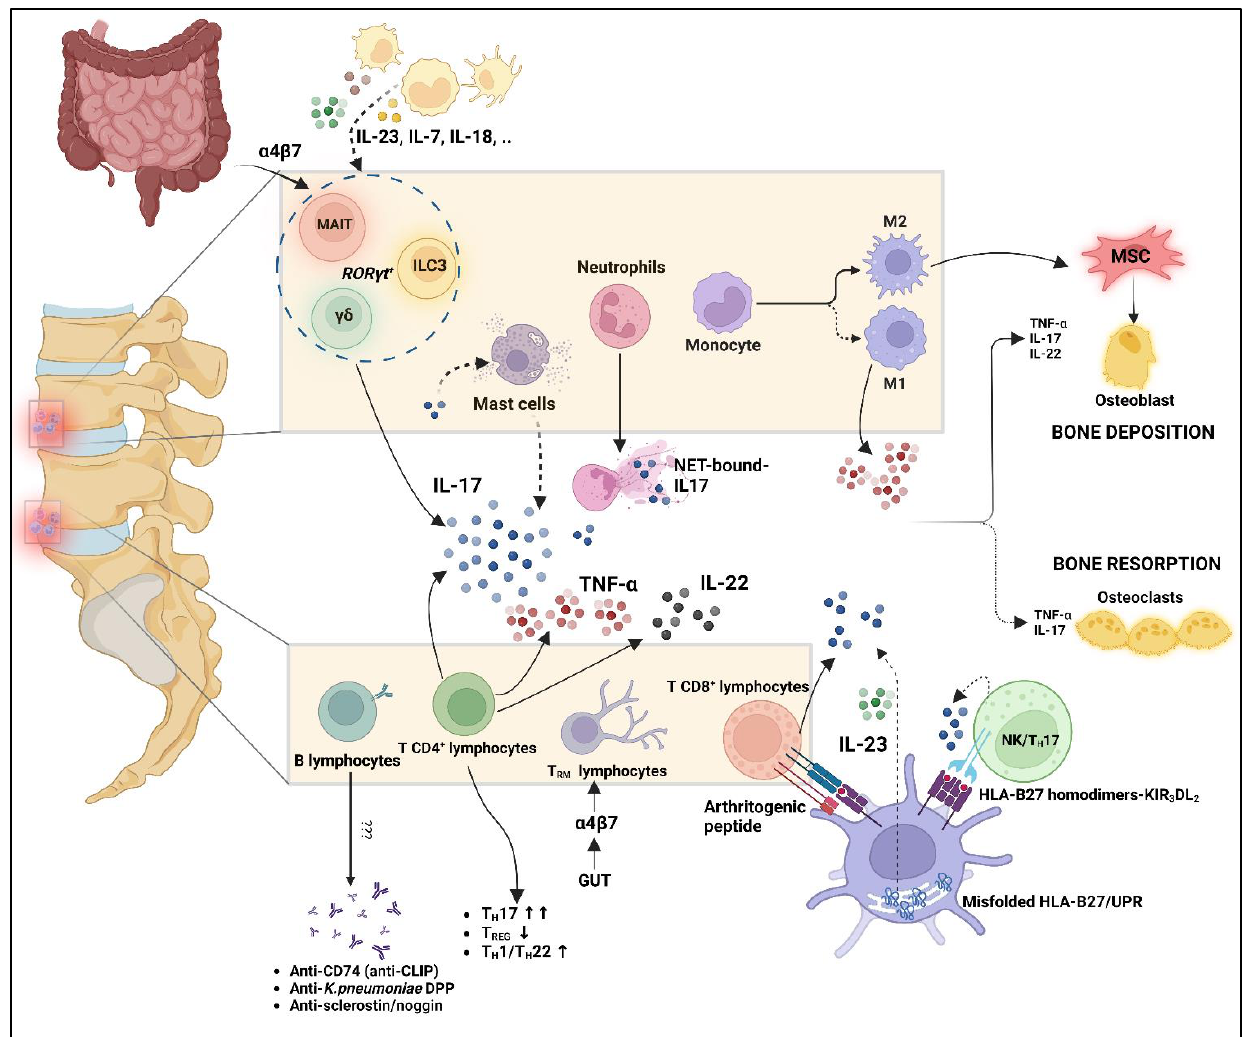
Figure 2. Interplay of innate and adaptive immune system in axial-SpA pathogenesis. Mast cells are not able to produce IL-17; however, they may capture it from extracellular environments and release it after unknown stimulus. NET-bound-IL17 has been demonstrated useful, along with its capability to induce osteogenic differentiation of MSC. Myeloid cells can produce a large amount of proinflammatory cytokines, which may also act on innate-like lymphocytes and innate lymphoid cells such as MAIT, ILC3 , and γδ T cells. Not only these cells, but also the T RM lymphocytes, may concentrate in axial enthesis following migration from the gut, as suggested by intestinal homing markers such as the α 4 β 7 integrin on their surface (gut–joint axis). T cells play a predominant role among adaptive immunity, with an imbalance between T H 17 and T REG cells, but also T H 1/22 upregulation. T CD8 + cells may be activated after presentation of arthritogenic peptide by HLA-B27. HLA-B27 may also contribute to IL-23/IL17 upregulation due to UPR activation and B27 2 binding of KIR 3 DL 2 receptors on the NK/ T H 17 cell surface. This cellular interplay leads to an aberrant production of proinflammatory cytokines such as TNF- α , IL-17, and IL-22, which in turn may dysregulate bone homeostasis along with M2 macrophages. B lymphocytes are traditionally considered less relevant even if antibody production has been demonstrated. MAIT: mucosal-associated invariant T cells; ILC3 : innate lymphoid cells 3; MSC: mesenchymal stem cells; UPR: unfolded protein response. “Created with